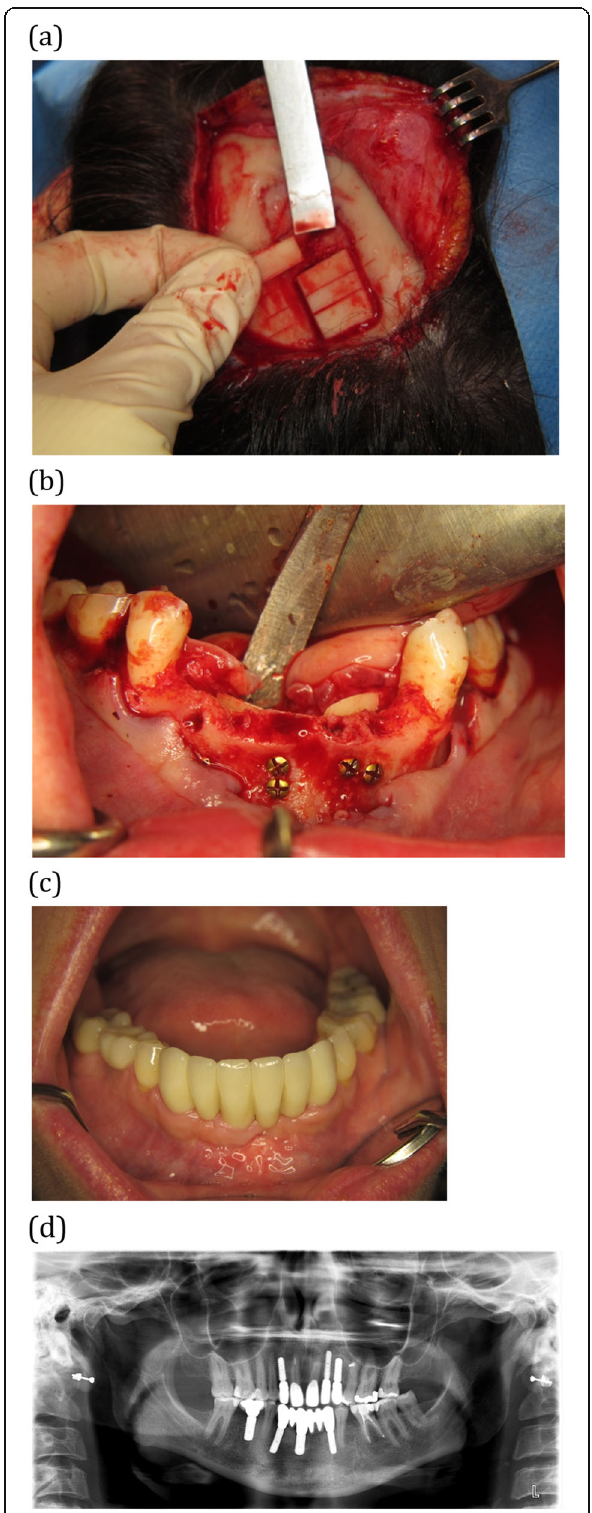
Fig. 2 A 43-year-old female with oligodontia with missing tooth numbers 12, 22, 23, 35, 33 – 43 and 45. a Harvesting of outer table calvarial bone blocks. The blocks were harvested piece-by-piece. b Reconstruction of the mandible at tooth locations 33 – 43 by placing the calvarial grafts lingually. The grafts were fixed with screws from the buccal side. The implants were placed after 4 months. c Clinical image of the end result. A fixed bridge was made in the region 33 – 43. d Orthopantomogram of the end result at 21 months follow-up showing negligible marginal bone loss around the